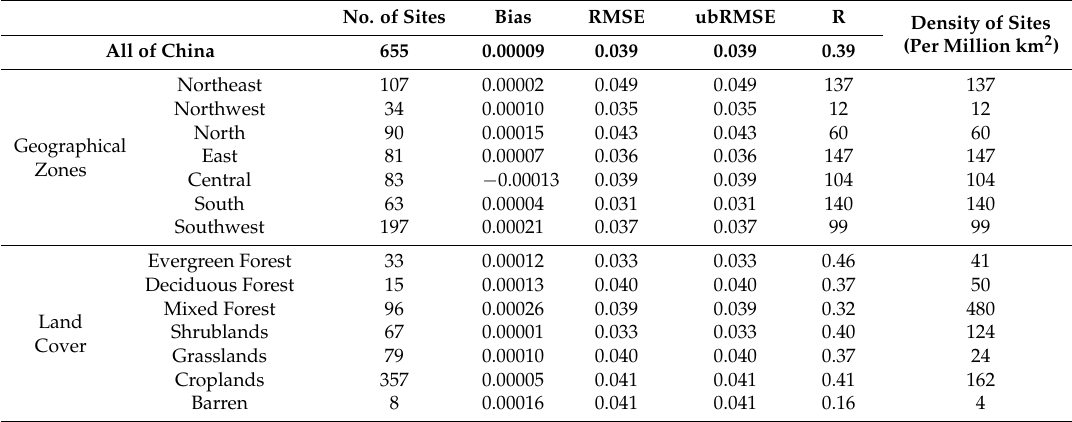
Table 2. The differences between SMAP radiometer soil moisture retrievals and in situ soil moisture observations over continental China based on anomaly data (1 April 2015–31 August